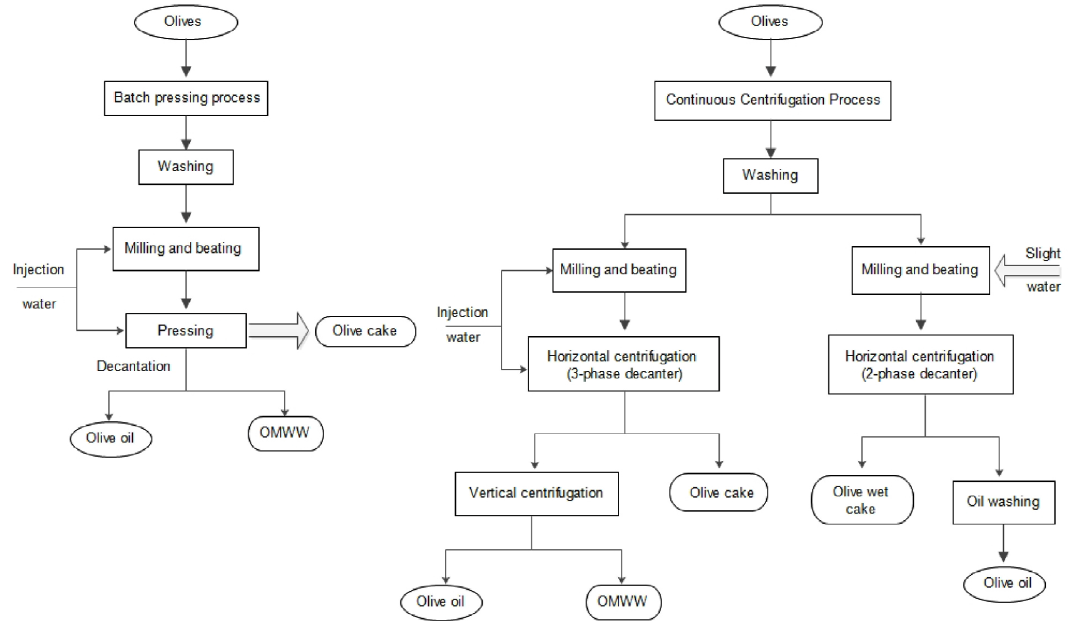
Fig. 2. Conventional and new processes for olive oil